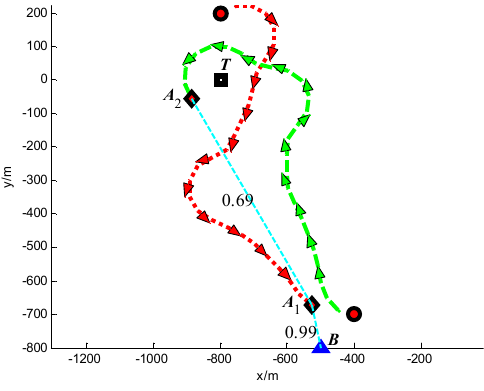
Figure 22. Trajectories of UAVs at t = 10 s (Group B in Scenario 2). Appl. Sci. 2018 , 8 , x FOR PEER REVIEW